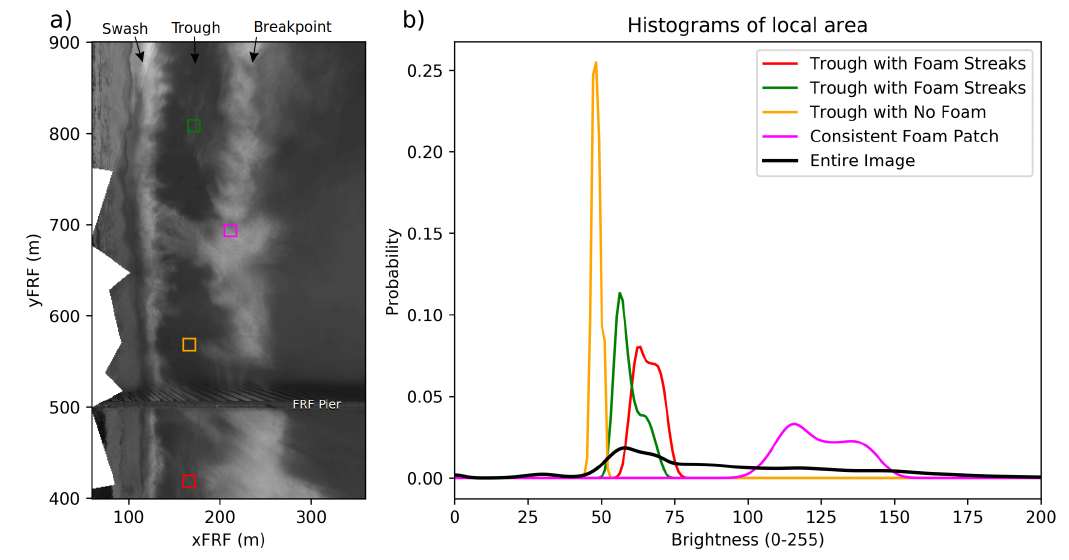
Figure 3. ( a ) Four local regions are highlighted in an example wave-averaged movie (WAM) frame composed of foam streaks in the trough and more persistent foam patches were waves break. ( b ) Distributions of pixel brightness obtained for each local region highlight notably different means values and distribution widths depending on the presence of foam streaks or